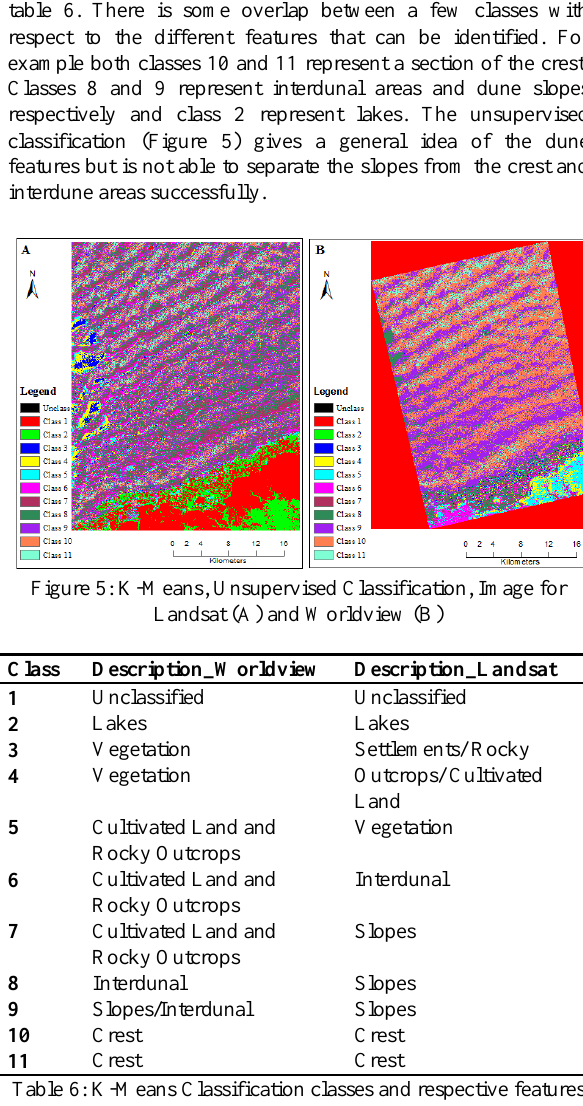
Figure 8: Change Detection Difference Maps of Landsat